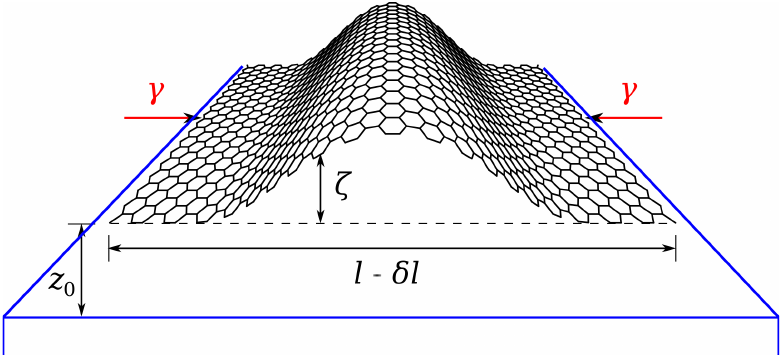
Figure 1. Geometry of buckling for a graphene ribbon of width l physisorbed on a substrate at the equilibrium distance z . The two edges of the ribbon, supposed to be clamped, are 0 submitted to a normal tension (cid:13) uniformly distributed along the